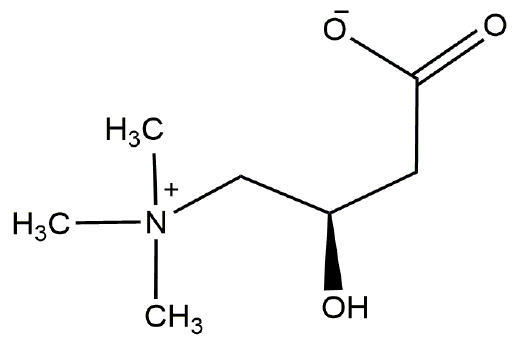
Figure 1. Chemical structure of L-carnitine.